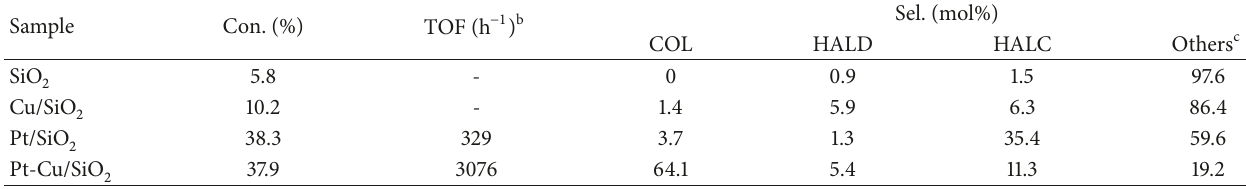
Table 3: Catalytic activities of Pt-Cu/SiO catalysts for the hydrogenation of CAL a .